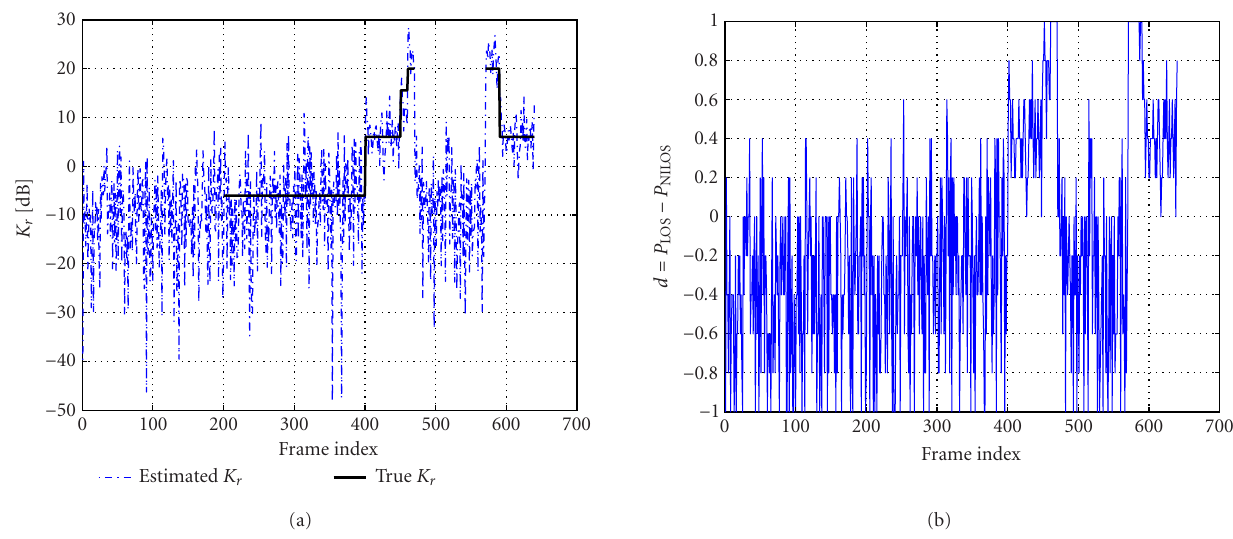
Figure 7: Estimated Rician factor K r (plot (a)) and the probability distance d (plot (b)). Channel profile: combined Rayleigh-Rician and v = 22 .